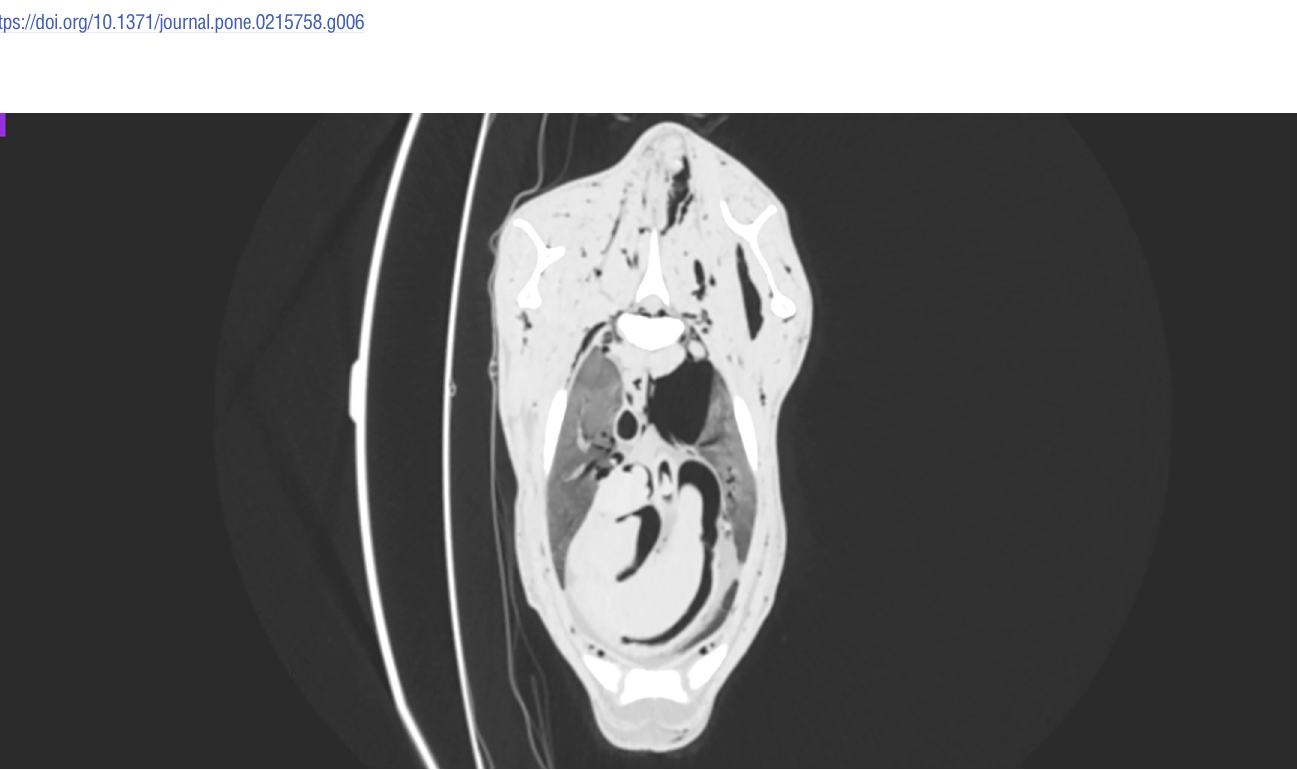
PLOS ONE | https://doi.org/10.1371/journal.pone.0215758 April 23,